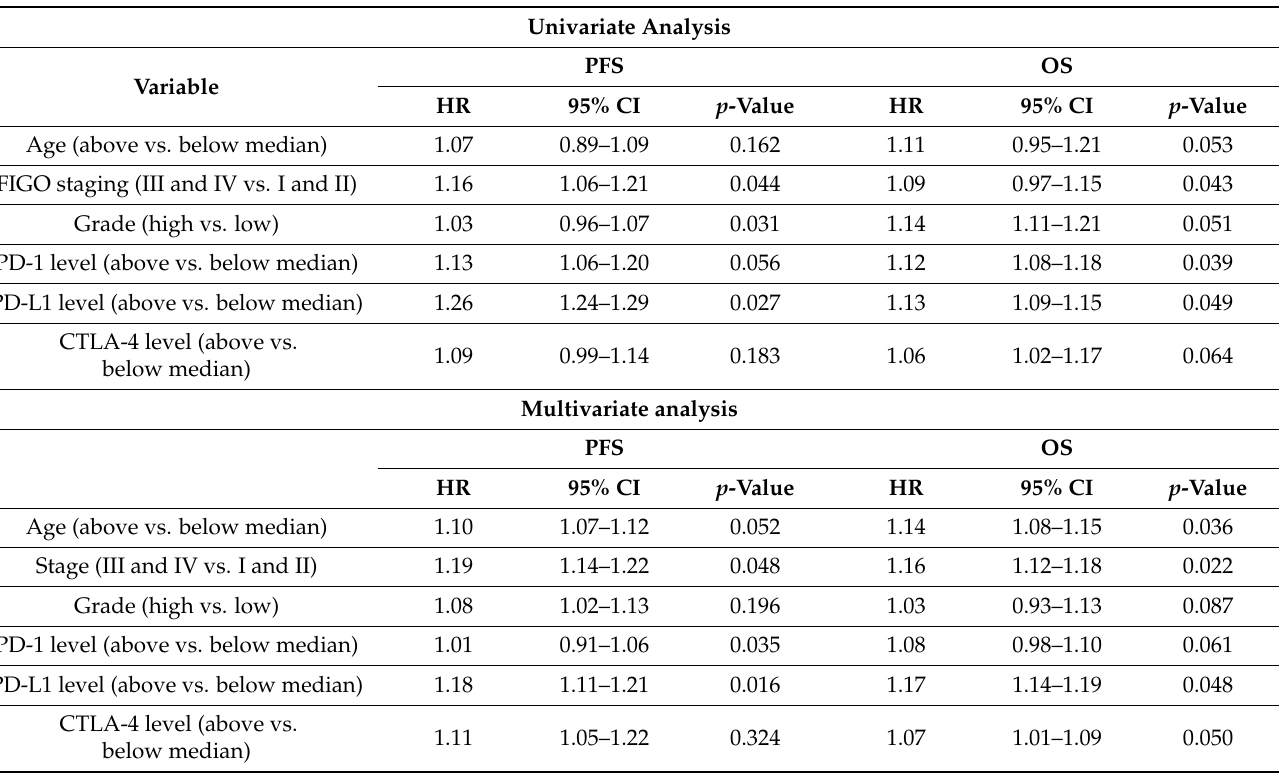
Table 8. Univariate and multivariate Cox regression model for serum concentrations of the proteins studied.